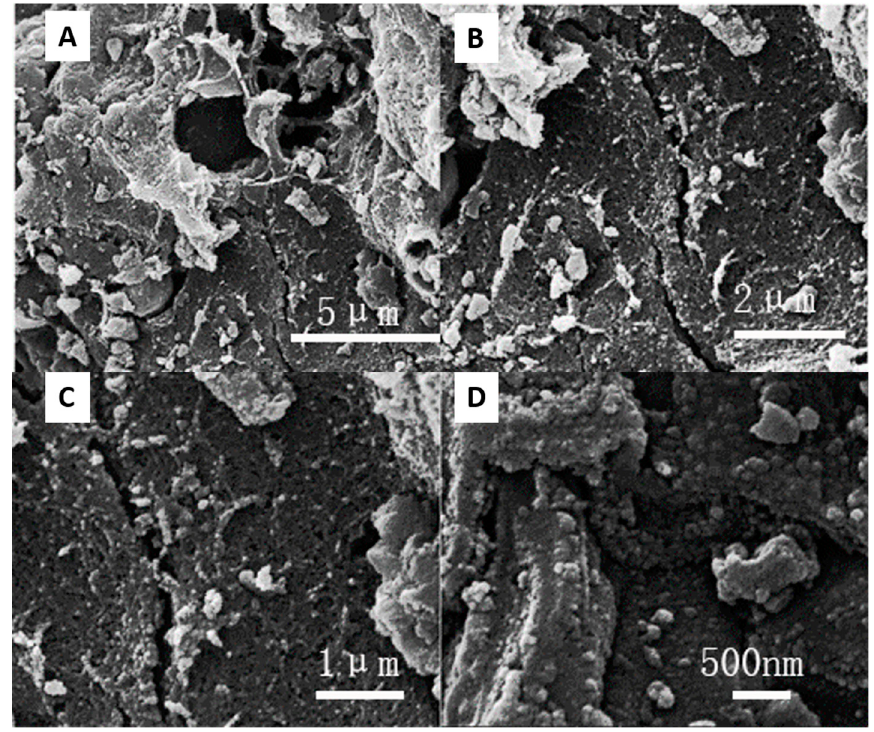
Figure 5. SEM of Co-PKEC with different magni fi cation.